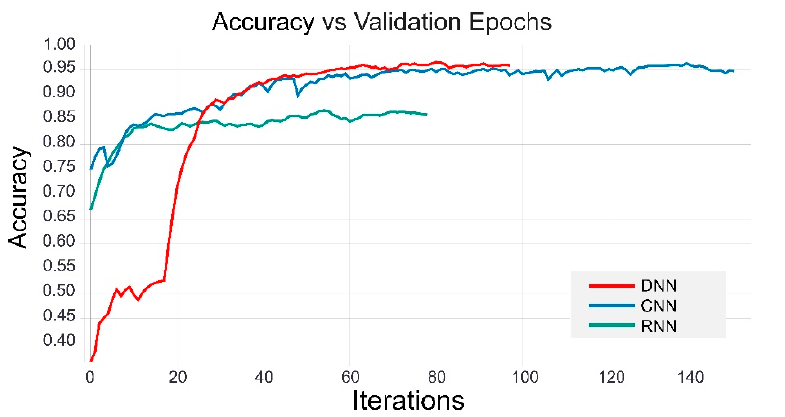
Figure 7. Plot showing the improvement in accuracy during the validation process for DNN (red), CNN (blue), and RNN (green).